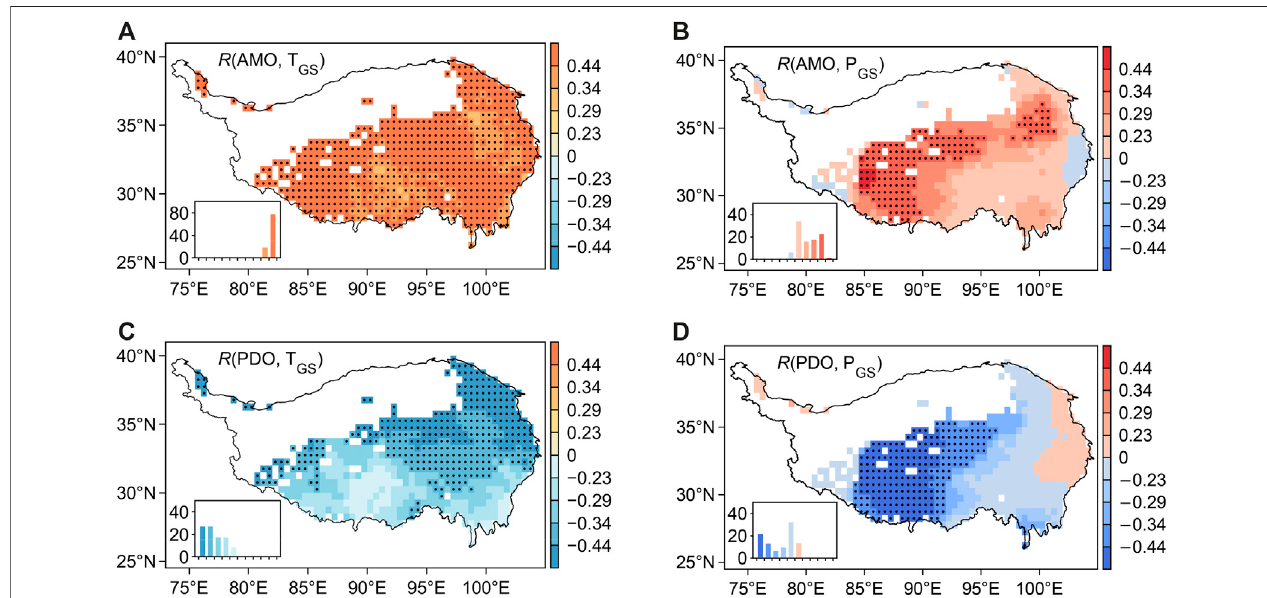
FIGURE1| Spatialpatternofcorrelationcoef fi cients( R )betweeneachoftheAMOandPDOindicesandeachoftheannualT GS andP GS metricsacrosstheTPover the period 1982 – 2015. R (cid:2) ± 0.44, R (cid:2) ± 0.34, R (cid:2) ± 0.29,and R (cid:2) ± 0.23 correspond tosigni fi cance levels P (cid:2) 0.01, P (cid:2) 0.05, P (cid:2) 0.10, and P (cid:2) 0.20,respectively. Pixels with dots were statistically signi fi cant ( P < 0.05). Bottom-left inset in each map shows the percentage of pixels in each interval of correlation coef fi cient with the interval value indicated by the color in the legend in the right. The pixels with mean annual NDVI lower than 0.10 were excluded (see method for detail).